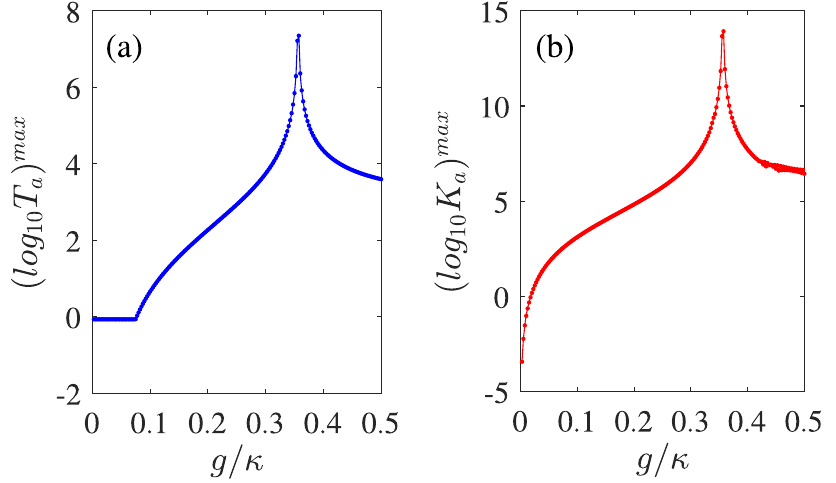
Figure 5. The maximal logarithms of the linear transmission rate T a ( a ) and the third-order nonlinear intensity K a ( b ) versus the QE-cavity coupling strength g in the PT -symmetric case of κ b = − κ . Other parameters are the same as those in Figs 2 and